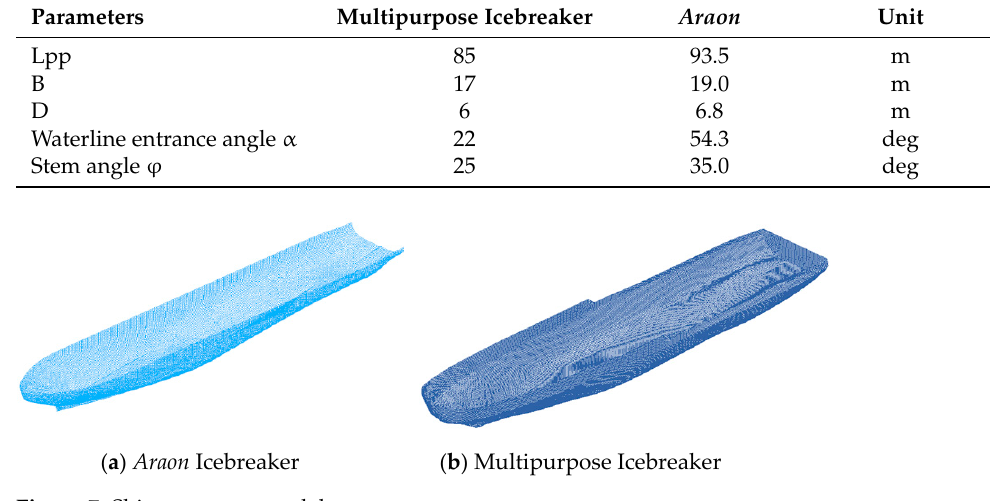
Figure 7. Ship geometry model.